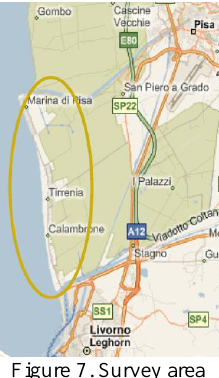
Figure 7. Survey area